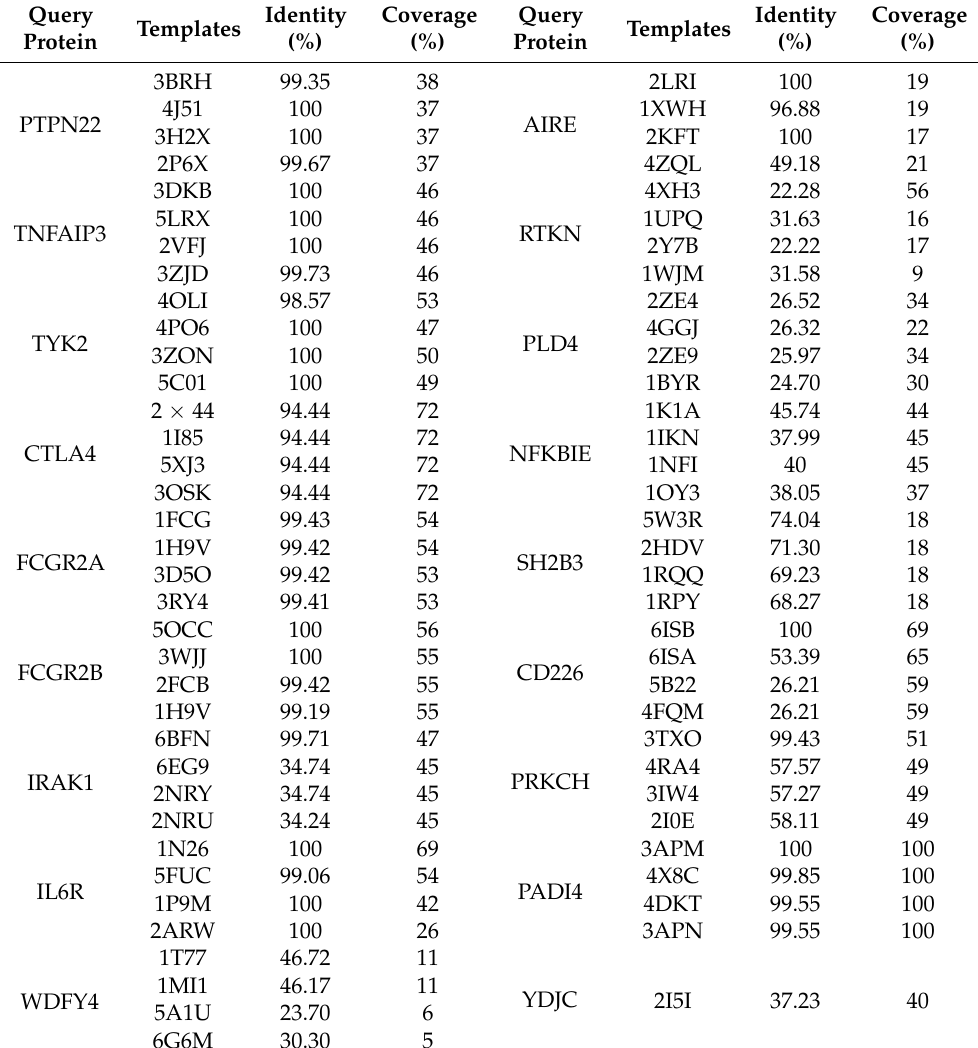
Table 6. Percentage identity and coverage of the best-matching templates for query